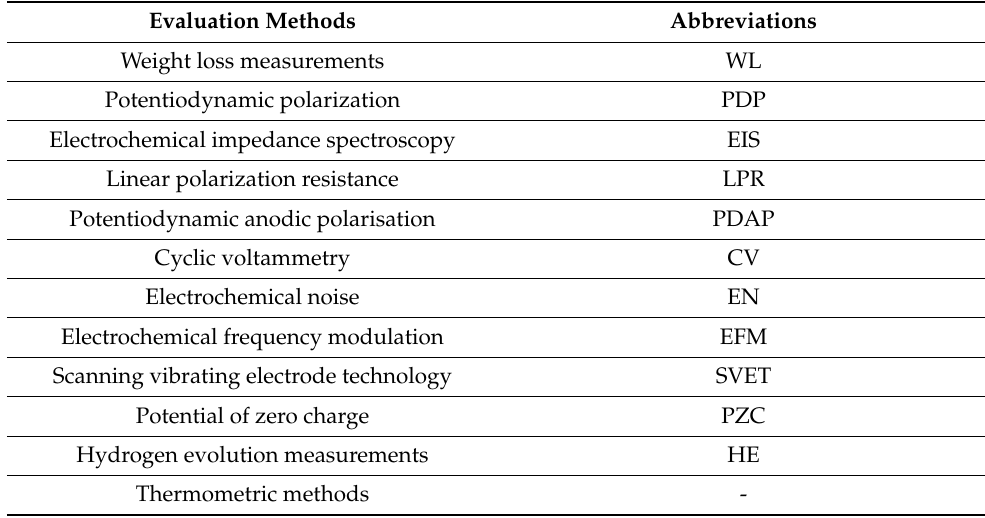
Table 2. Methods used for evaluating corrosion inhibition